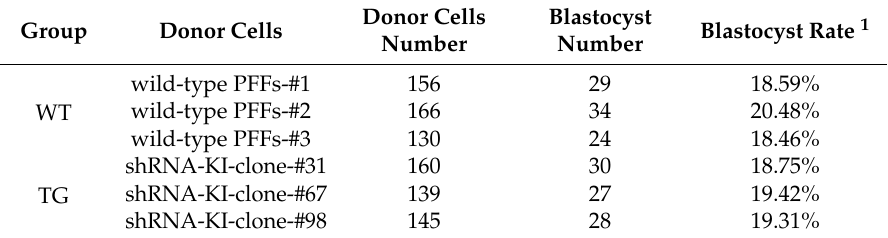
Figure 6. qPCR detection and Cell proliferation assay in TG PFF clones. ( A ) Relative expression levels of miRNAs expressed from the p miR-17-92 cluster in positive PFF clones #31 and #67 were confirmed by qPCR. All values are the mean ± S.E.M., n = 3. No significant difference was found among the groups. ( B ) The effect of the anti-CSFV shRNA insertion on cell proliferation in positive PFF clones. All values are the mean ± S.E.M., n = 3. No significant difference was found among the groups. Table 2. Summary of blastocyst development in the WT and TG